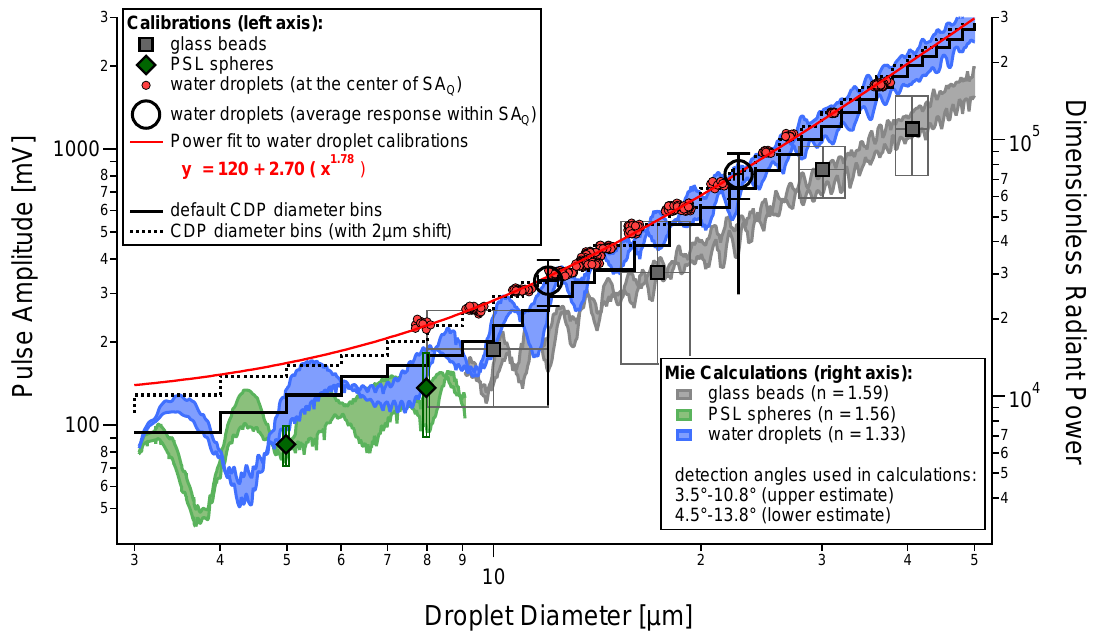
Fig. 4. CDP sizer pulse amplitude (in milliVolts, on the left axis) versus the “true” droplet diameter (obtained from images of the droplet glares) within the sample area of the CDP for calibrations using glass beads, polystyrene latex (PSL) spheres and water droplets. Also plotted are the calculated response functions of the CDP (dimensionless radiant power collected, on the right axis) as a function of droplet diameter, calculated using a given range of collection angles and refractive indices. The scales of the two axes are adjusted to obtain alignment between the calibrations and the theoretical curves. Uncertainties in the glass bead and PSL particle sizes represent one standard deviation as provided by Fischer Scientific, Inc. Uncertainties in the pulse amplitude are one standard deviation of the observed pulse